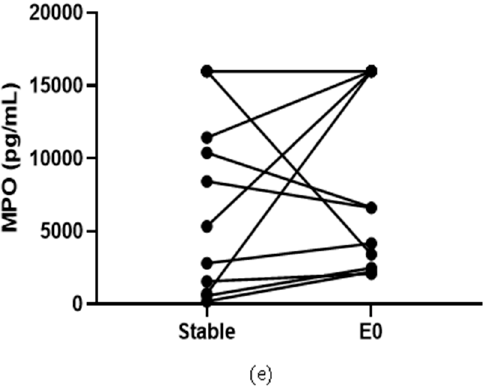
Figure 2. Sputum Biomarkers in COPD Stable and Exacerbating Samples : ( a ) IL-1 β , data is presented as paired concentrations, data analysed using Wilcoxon signed rank test. ** p ≤ 0.01. ( b ) IL-6, data is presented as paired concentrations, data analysed using a paired t -test. * p < 0.05. ( c ) TNF- α , data is presented as paired concentrations, data analysed using Wilcoxon signed rank test. ** p < 0.01. ( d ) IL-8, data is presented as paired concentrations. ( e ) MPO, data is presented as paired concentrations.